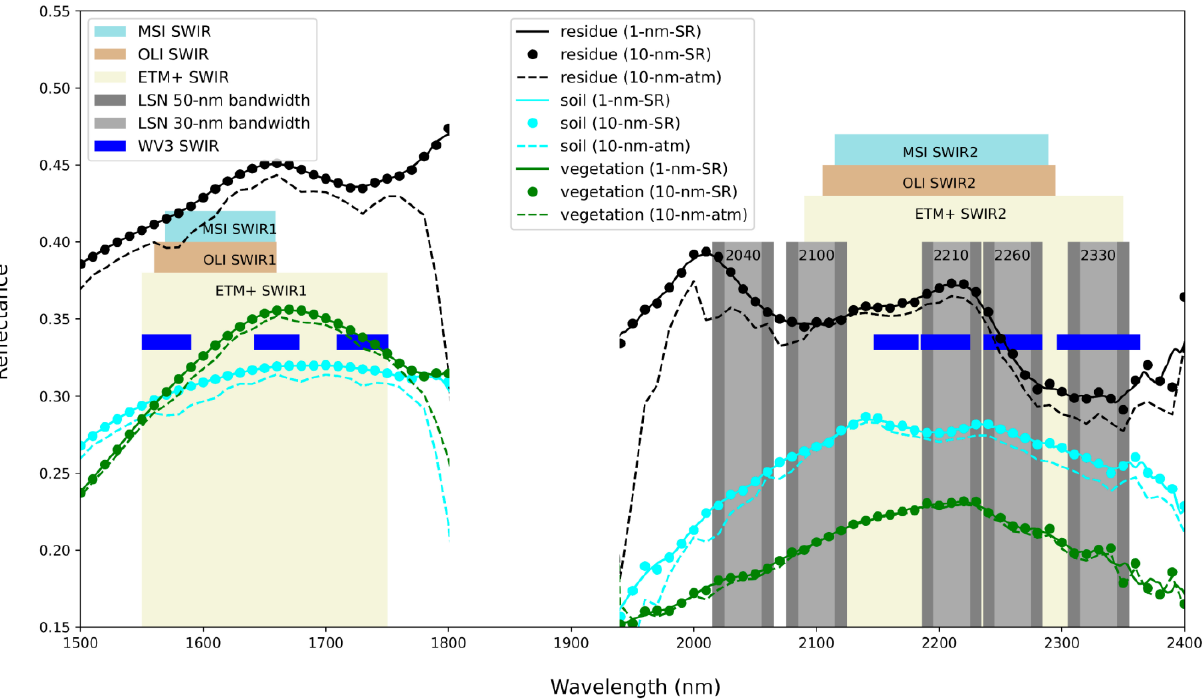
Figure 1. Comparison of SWIR bands on current multispectral sensors with field-collected spectra. The solid lines correspond to 1 nm interval (30 nm bandwidth) spectra, the points correspond to surface reflectance (SR)-processed 10 nm spectra, and dashed lines correspond to 10 nm spectra with atmospheric artifacts (atm-processed). The 10 nm spectra provide an illustration of imaging spectrometer capabilities, e.g., PRISMA and AVIRIS, with and without atmospheric correction. Previously evaluated Landsat Next (LSN) bands are depicted with gray bars [37]. For LSN bands, a combination of 2040, 2100, and 2210 nm bands corresponds to an absorption-centered index, e.g., CAI, and a combination of 2100, 2210, and 2260 nm corresponds to a peak-centered index, e.g., LCPCDI. Crop residue lignocellulose absorption features at 2100 and 2300 nm are effectively identified by LSN bands, and WV3 bands for the 2300 nm feature. Current Landsat/Sentinel-2 SWIR bands do not accurately resolve these absorption features.